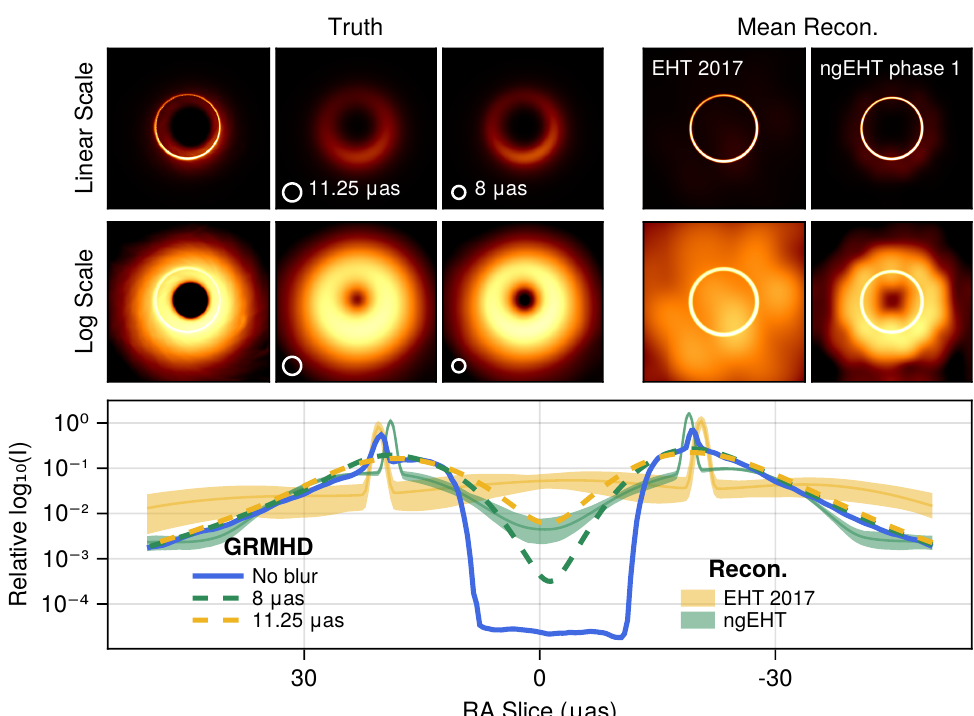
Figure 8. Similar to Figure 7 except fitting the thin ring hybrid model. In this case, the profiles show localized peaks associated with the thin ring, but they are displaced from the profile peaks of the n = 1 photon